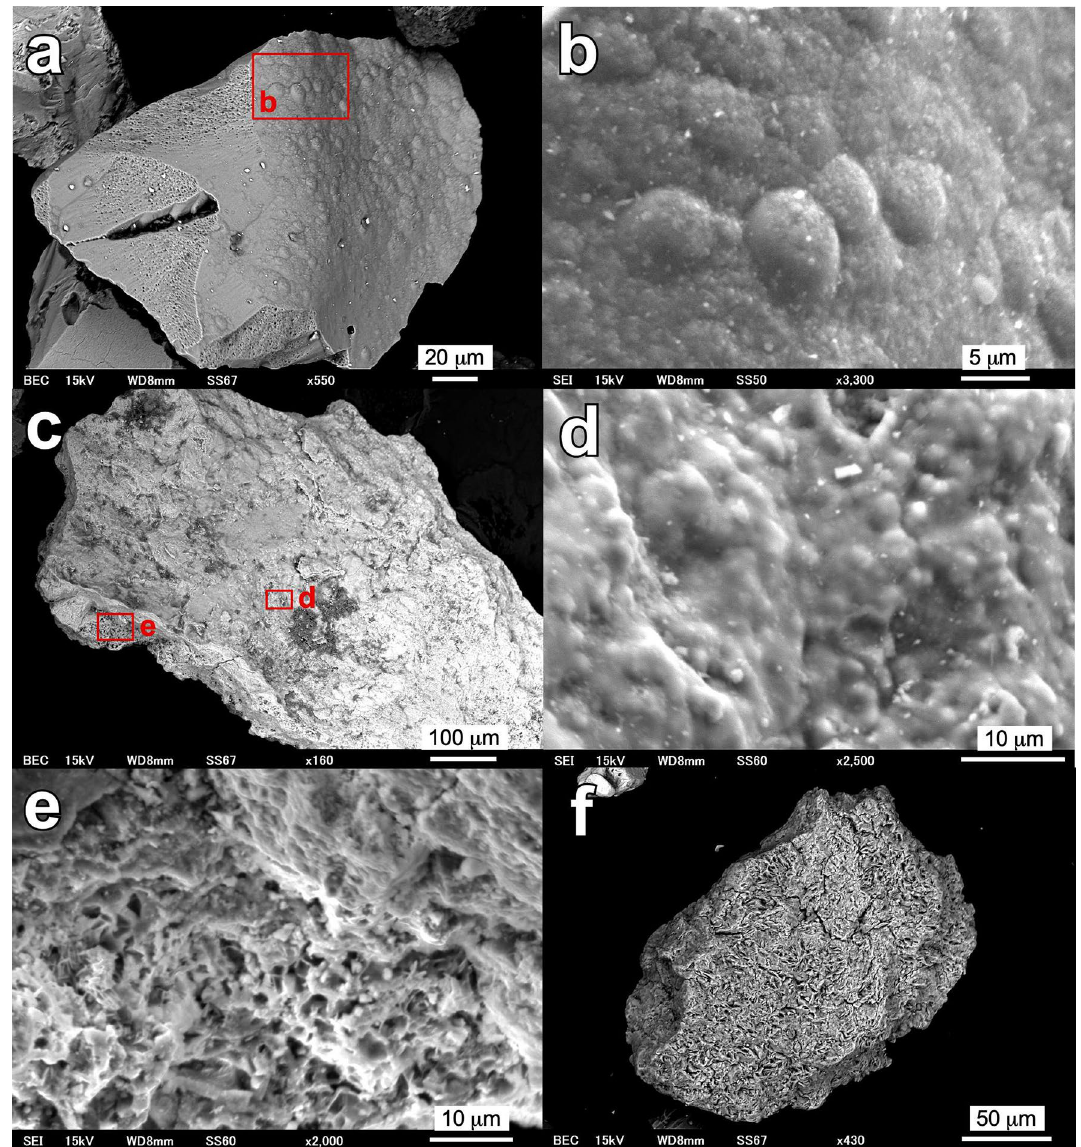
Figure 8. Electron micrographs showing the morphology of Fe-hydroxide in gaerome clay (A07). SEI ( a – d ) show rugged crusts and rounded lumps on the surface of Fe hydroxide. Electron micrographs ( e ) (SEI) and ( f ) (BSE image) show a sponge-like texture of the body of Fe-hydroxide